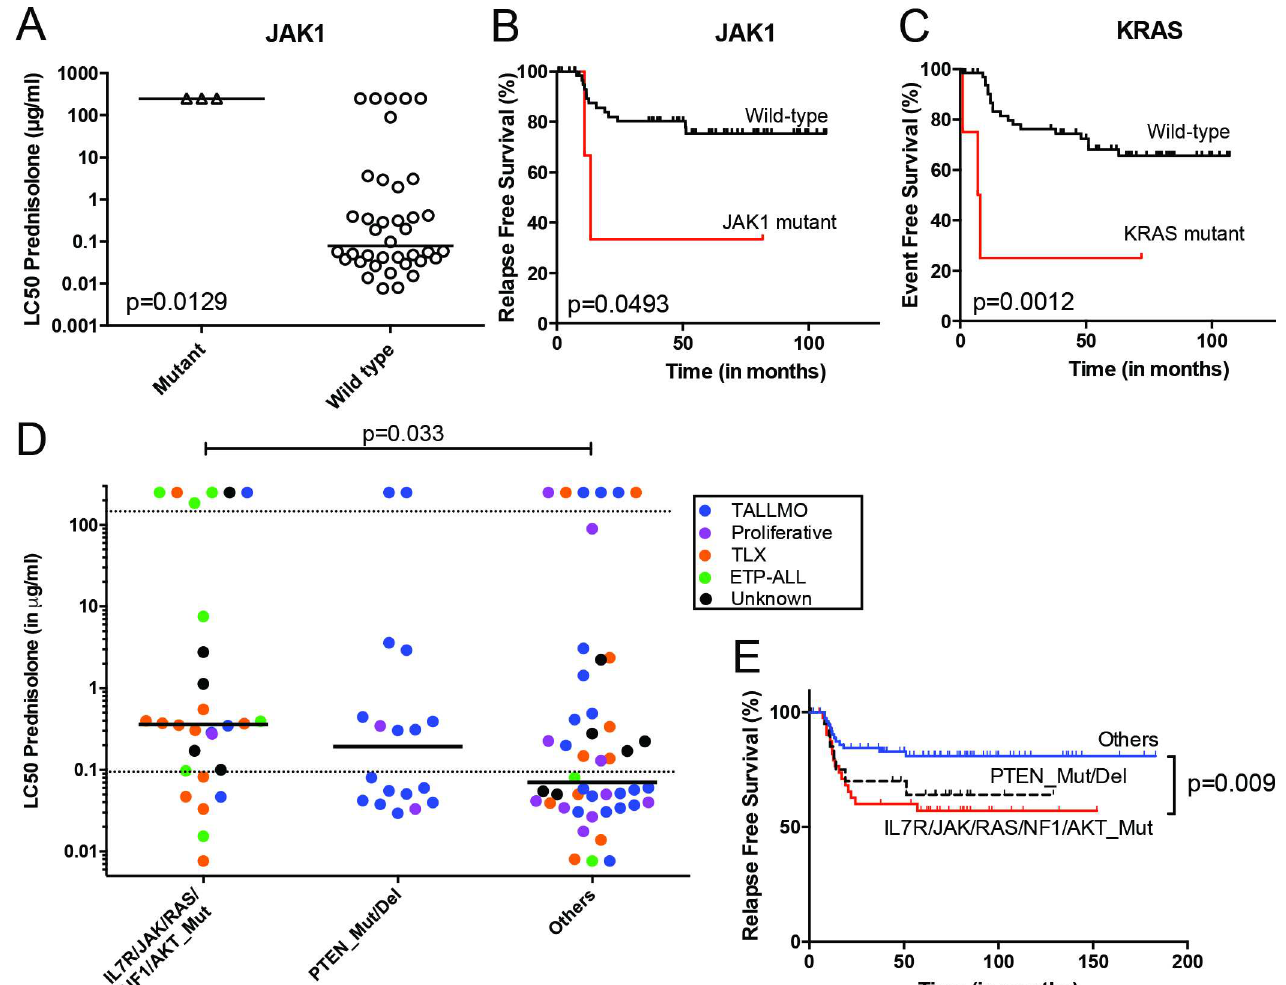
Fig 3. Mutations/aberrations affecting the IL7R signaling pathway in pediatric T-ALL patients at diagnosis predict diminished steroid response and poor outcome. Mutationsin (A and B) JAK1 or (C) KRAS detected by TES in diagnosticsamples from 69 T-ALL patients are associated with diminished steroid responseand/or poor survival. IL7R signalingmutationsin diagnosticsamplesfrom 146 T-ALL patients are associated with reduced(D) in vitro steroid sensitivity and (E) relapse-freesurvival. Patients harboring NR3C1 deletionas a consequence of a chromosomal 5q deletionwere excludedfrom these analyses. See also S6 Table. ETP-ALL, early thymic progenitoracute lymphoblastic leukemia; T-ALL, T cell acute lymphoblastic leukemia;TES, targeted exome